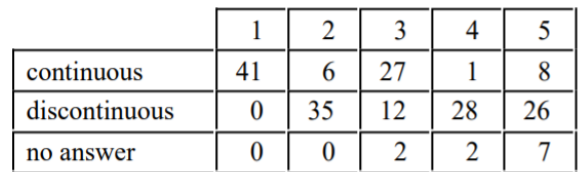
Figure 3.2 Tables from Tall and Vinner, 1981. It Summarises the results of the experiment.